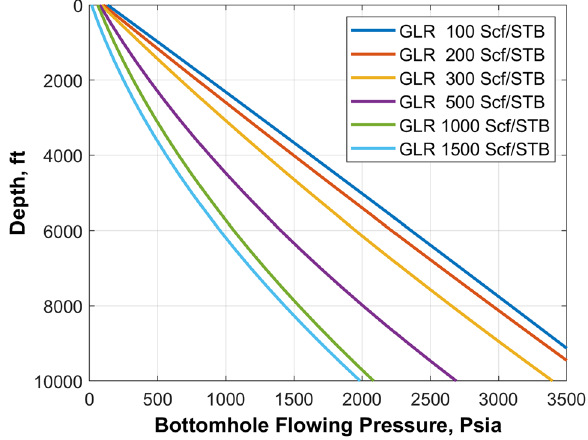
Fig. 12 Effect of changing depth with different gas–liquid ratios (GLRs) on flowing bottom-hole pressure at tubing diameter of 4.000